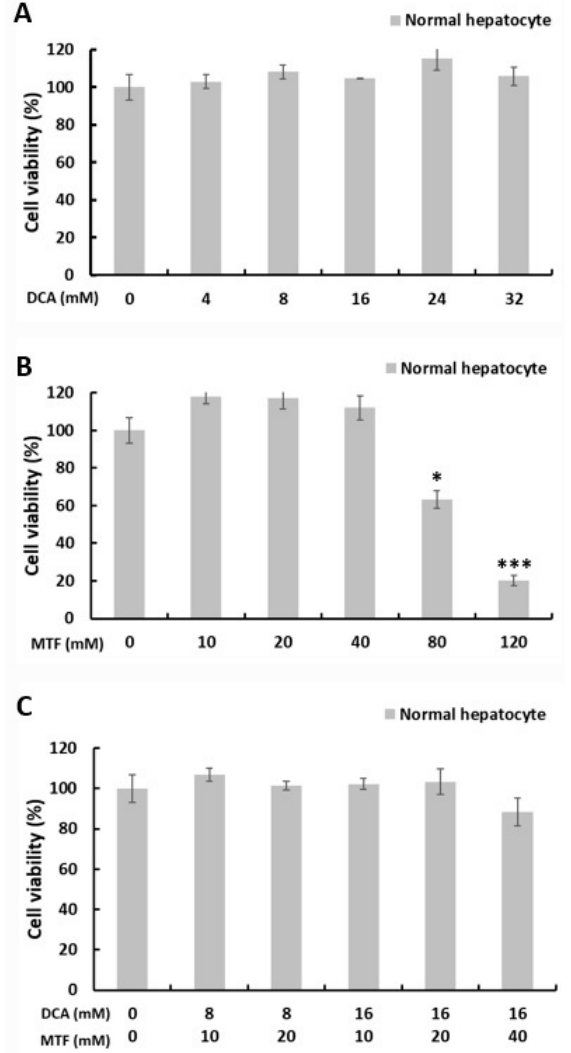
Figure 2. Co-treatment with metformin and DCA did not show cytotoxicity in primary normal hepatocytes. Primary normal hepatocytes were treated with the indicated concentrations of metformin and DCA for 24 h. ( A ) There was no cytotoxicity of DCA on primary normal hepatocytes even at high concentrations compared to the control. ( B ) At low concentrations of metformin ( ≤ 40 mM), there was no significant cytotoxicity of metformin on primary normal hepatocytes; at high concentrations of metformin ( ≥ 80 mM), cytotoxicity of metformin on primary normal hepatocytes significantly increased compared to the control. ( C ) Co-treatment with metformin and DCA did not show cytotoxicity in primary normal hepatocytes compared to the control. * p < 0.05 and *** p < 0.001.